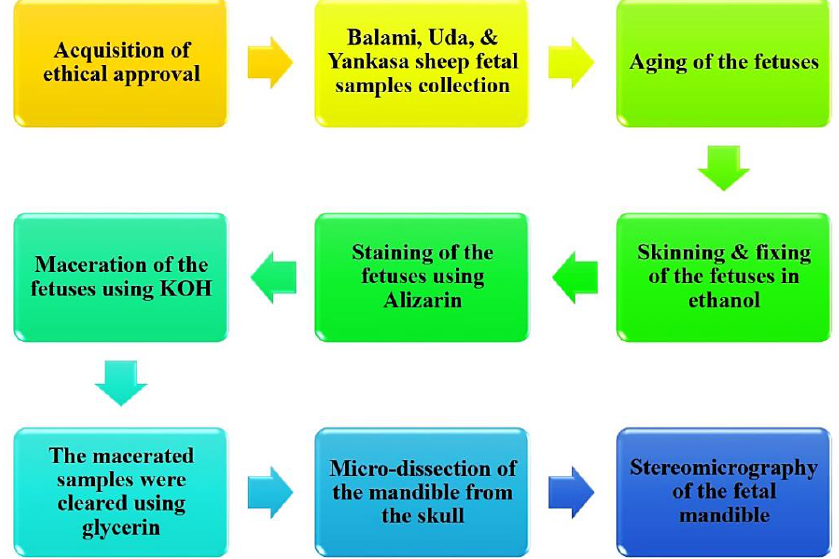
Figure 1. A flowchart showing the research